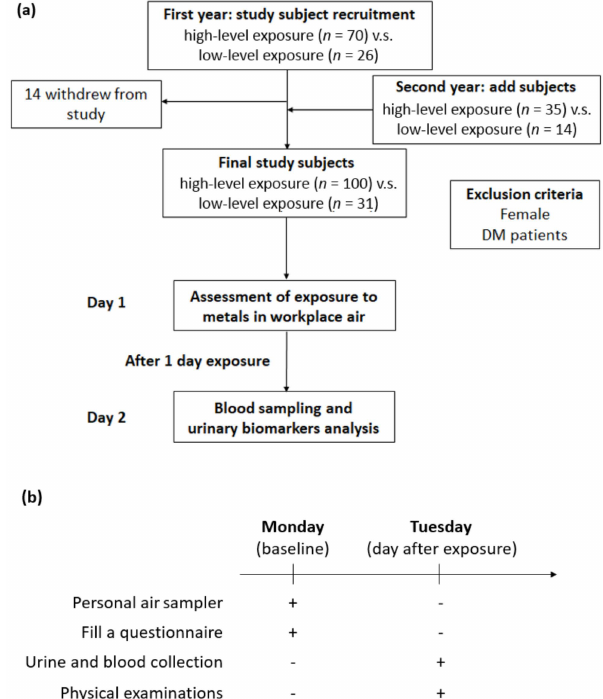
Figure 1. Experimental design for investigating the effects of metal fume fine on serum adiponectin in shipyard welders. ( a ) Flowchart of exposure assessment and subject recruitment. ( b ) Illustration of the experimental procedure for personal air sampler, urine collection, blood test, and physical